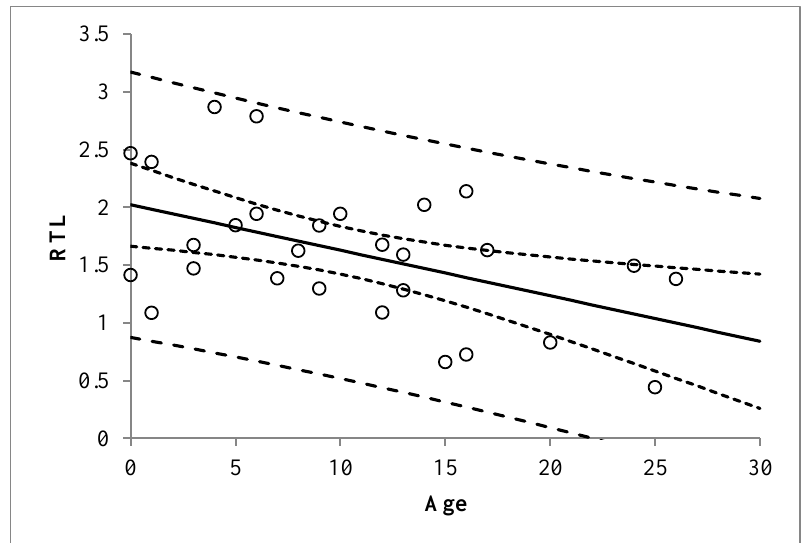
Fig. 1. The observed relationship between relative telomere length (RTL) and chronological age in 28 humpback whale samples. Solid line=trend line; inner stippled lines=boundaries of the 95% CI; outer stippled lines=boundaries of the 95% PI.